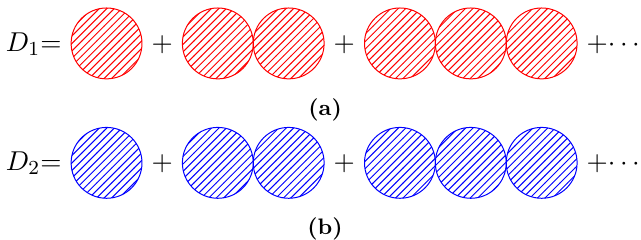
Figure 10. Diagrammatic expansions of D 1 and D 2 : the red blobs correspond to sector 1, while the blue blobs correspond to sector